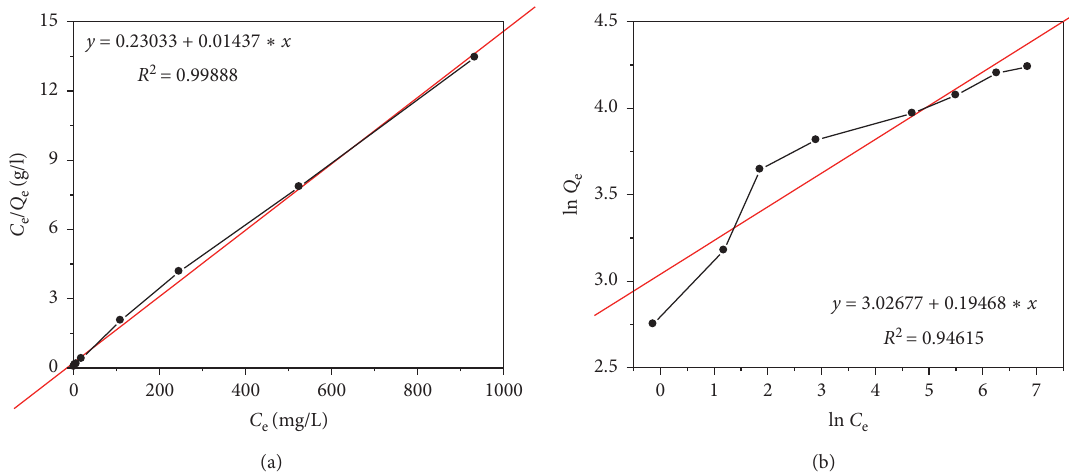
Figure 13: Adsorption isotherm curves of Cu 2+ follow the Langmuir (a) and Freundlich